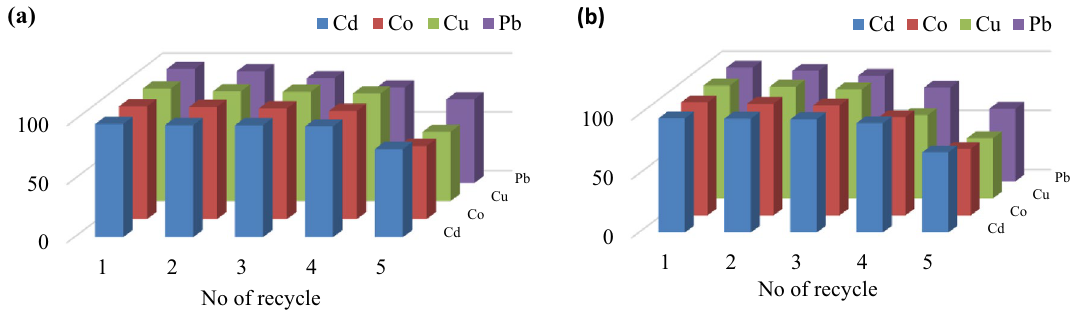
Figure 11. Recycle performance of ( a ) TPP-CMN and ( b ) V-CMN nano-sorbents.